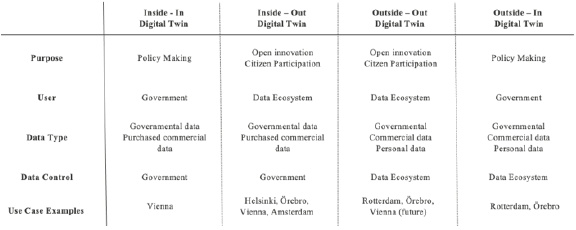
Table 2. Characteristics of the Urban Digital Twin Types.